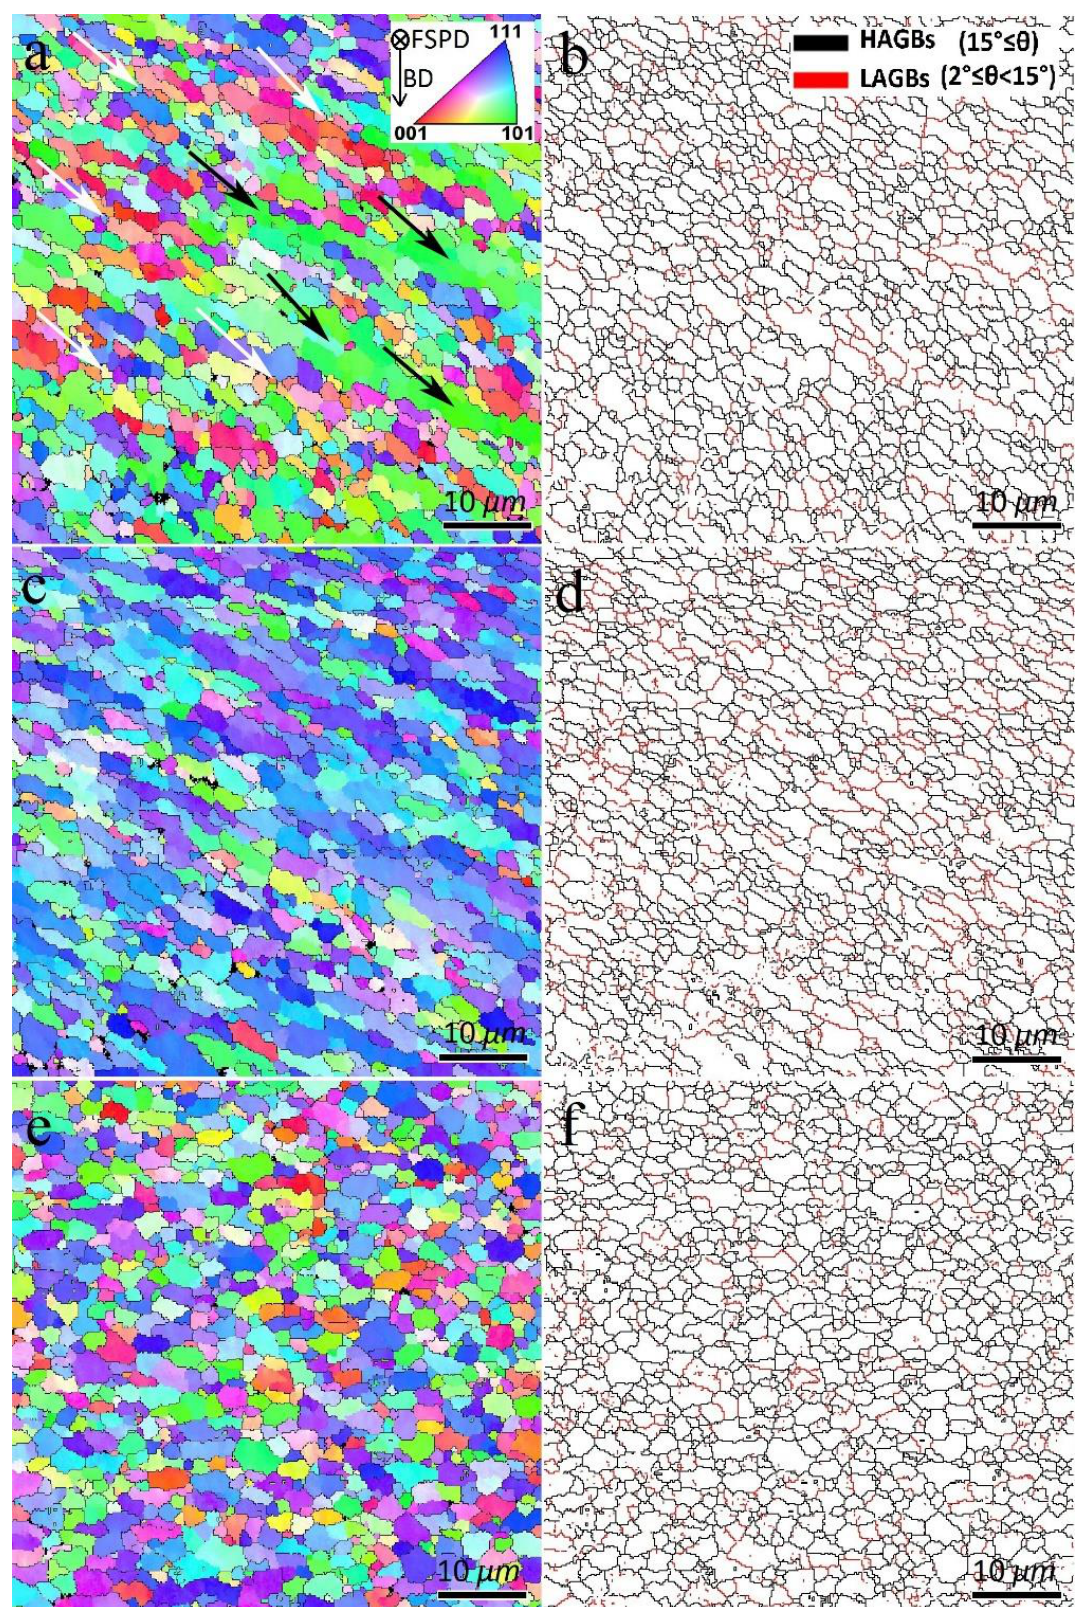
Figure 7. Inverse pole figure (IPF) and grain boundary (GB) maps of SZs: ( a , b ) S1, ( c , d ) S2, and ( e , f ) S3.